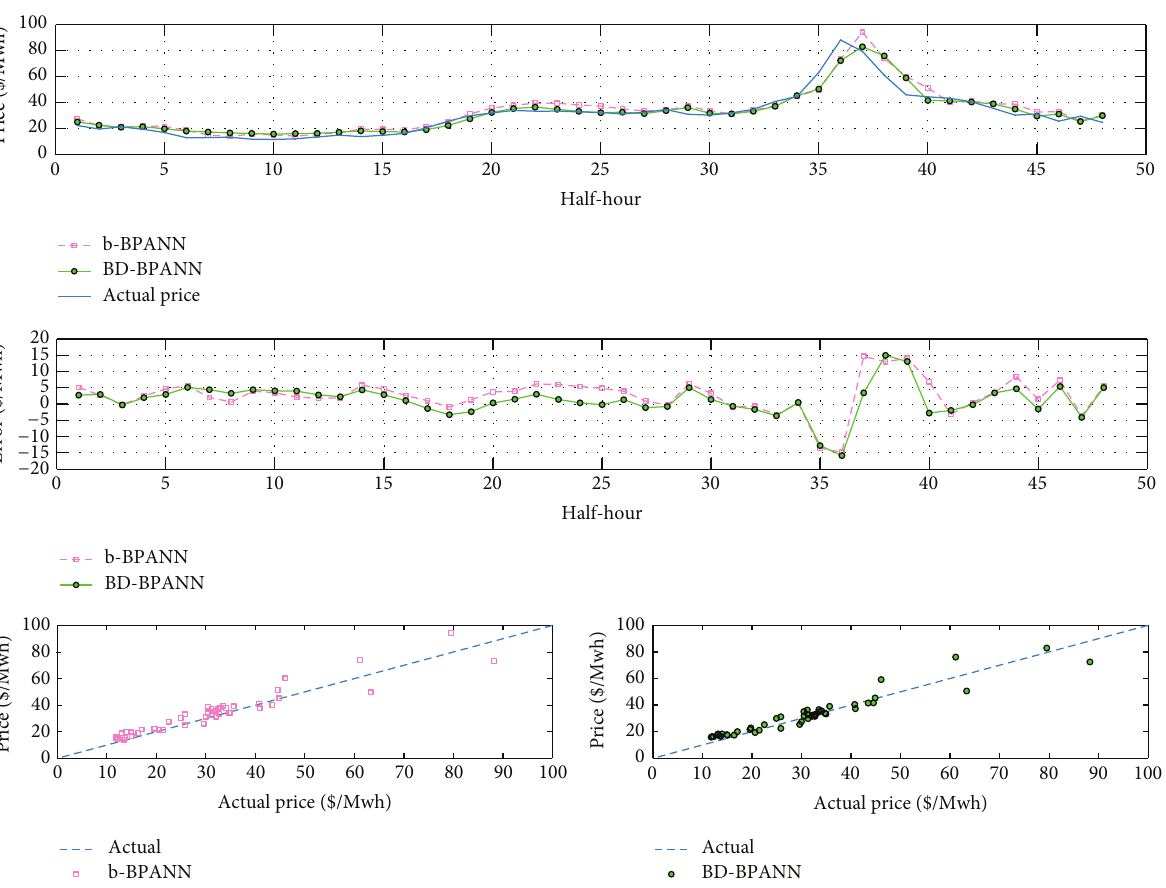
Figure 7: BPANN and BD-BPANN methods for case